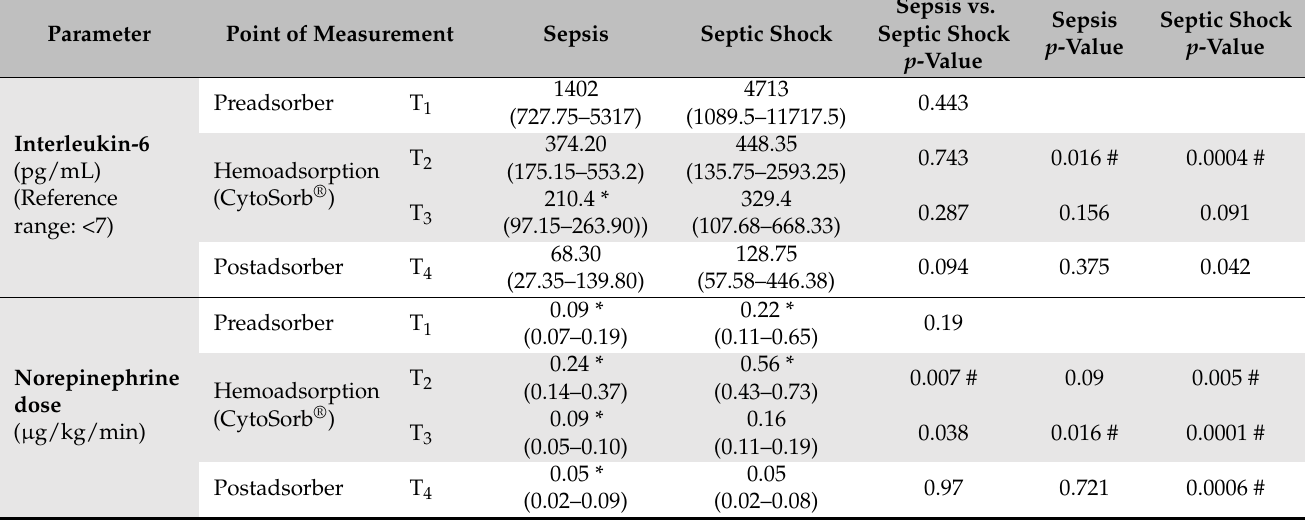
Table 4. Parameter of inflammation and shock reversal in sepsis and septic